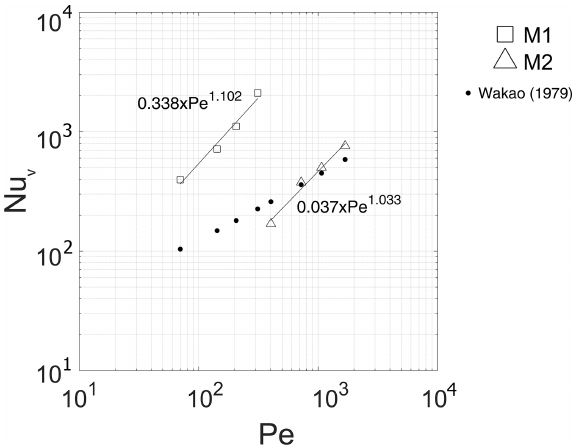
Figure 9. Heat exchanged J/(T inj − T 0 ) varying the specific rate q (ms − 1 ).